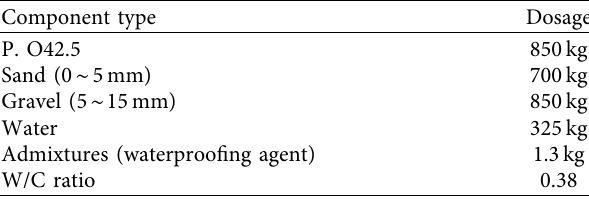
Table 1: Composition of the concrete mix.